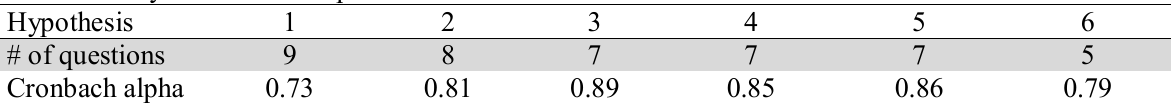
The summary of Cronbach